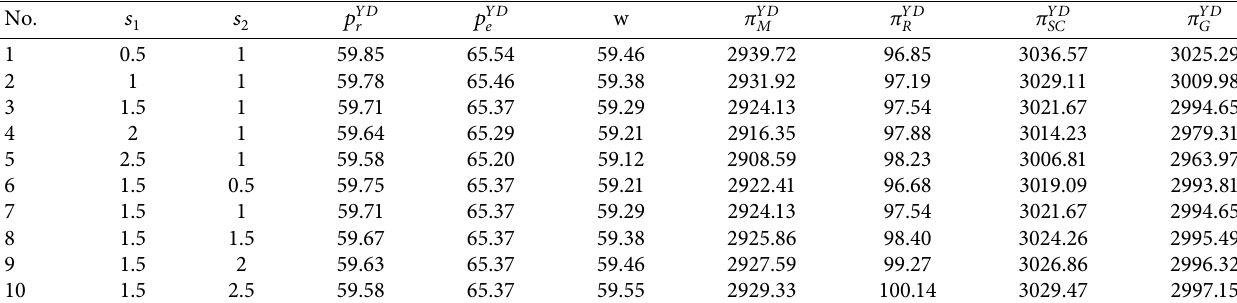
and s based on decentralized decision. 1 2